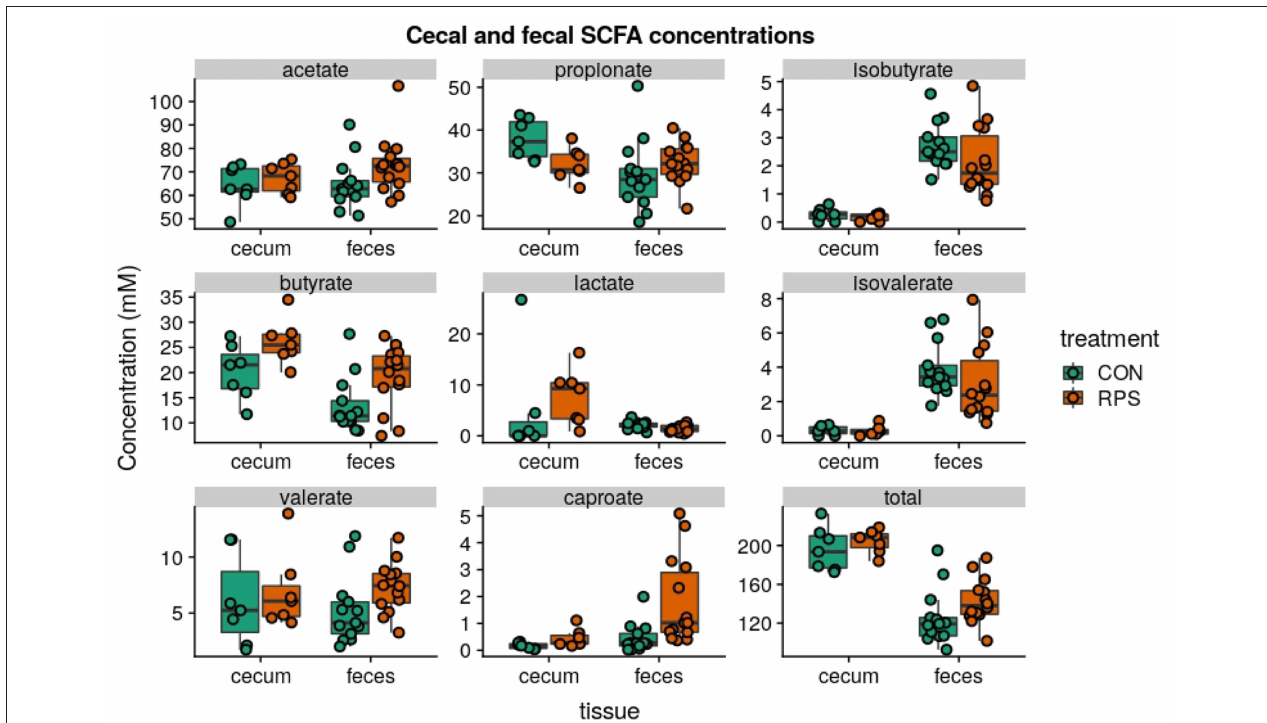
FIGURE 5 | SCFA concentrations (mM) from cecal contents and feces at day 21 post-weaning. Total SCFAs are the sum of the following SCFAs: formate, acetate, propionate, isobutyrate, butyrate, lactate, isovalerate, valerate, caproate, oxalate, phenylacetate, succinate, and fumarate. Group differences were tested with Wilcoxon tests, notable differences were as follows: butyrate: cecum p = 0.05 & feces p = 0.05, caproate: cecum p = 0.07 & feces p = 0.001, propionate: cecum p = 0.05, lactate: cecum p = 0.02 and feces p = 0.09, total: feces p =